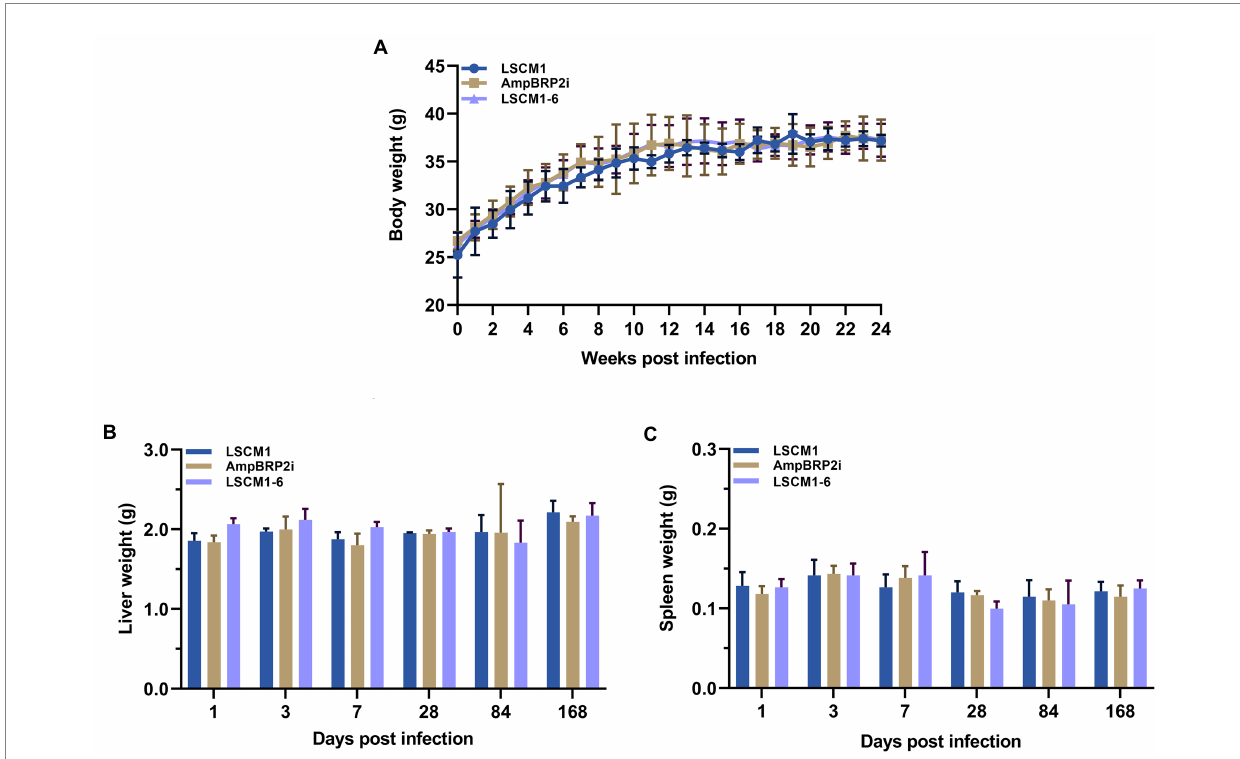
FIGURE 5 (A) Bodyweight of BALB/c mice infected with the L. martiniquensis LSCM1, AmpBRP2i, and LSCM1-6 stationary promastigotes. Animal weight was recorded every week. (B,C) Weight of liver and spleen collected from BALB/c mice infected with the L. martiniquensis LSCM1, AmpBRP2i, and LSCM1-6 stationary promastigotes.